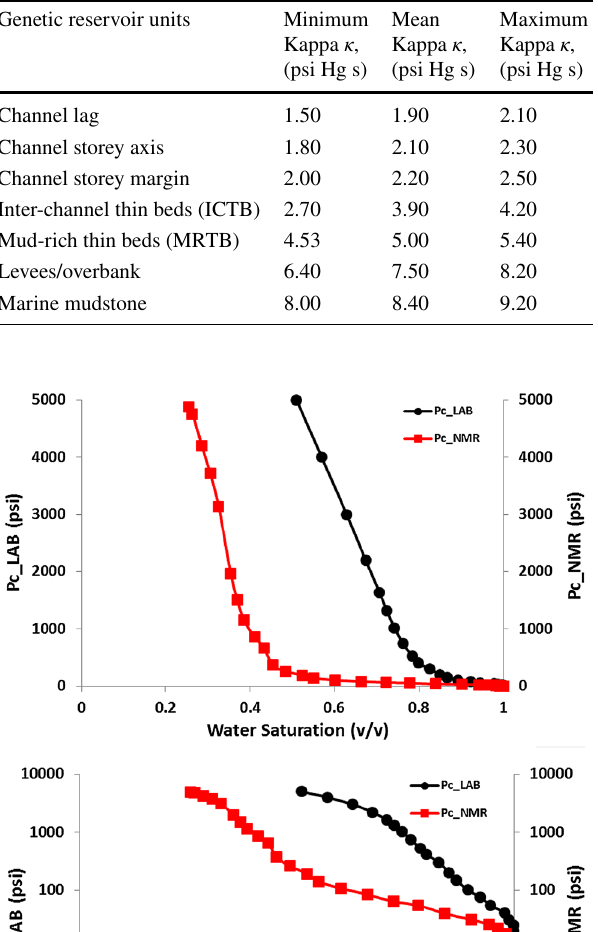
Table 4 Averages of genetic unit based kappa values for NMR capil- lary pressure modelling for the turbidites/deep water environment Genetic reservoir units